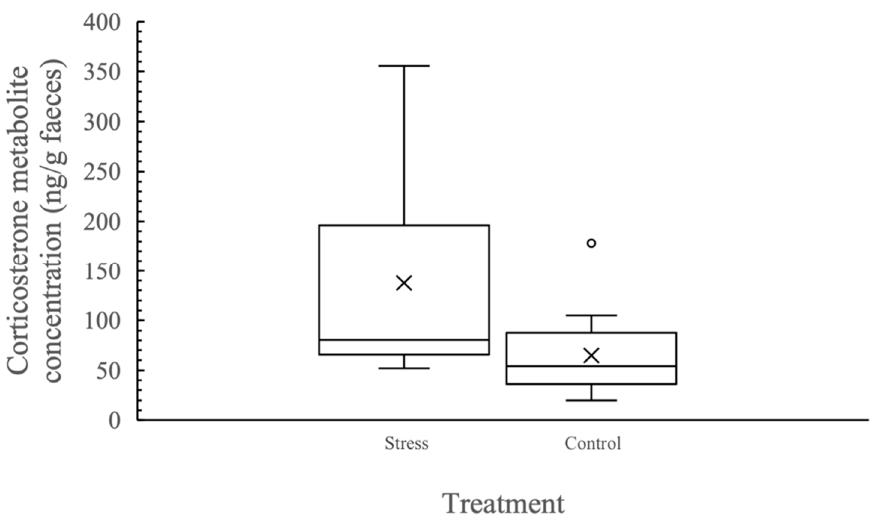
Figure 1. Boxplot graphs of faecal corticosterone metabolite concentrations (ng/g faeces) of individual fawn-footed mosaic-tailed rats ( Melomys cervinipes ) when undergoing testing (Stressed) and when not being tested (Control). The mean for each group is indicated by X.